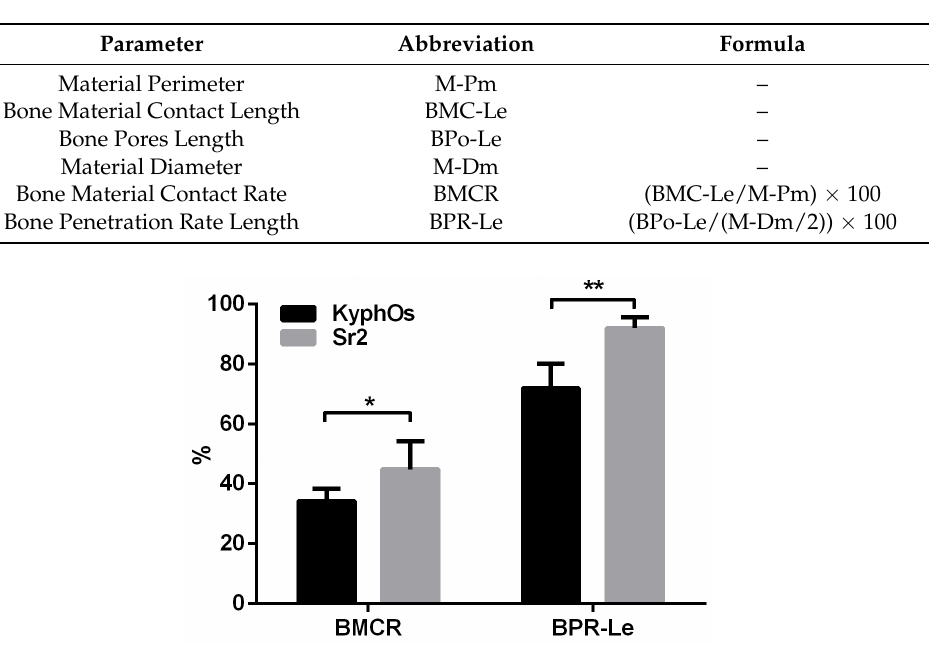
Table 4. Parameters observed and evaluated in histomorphometric analysis.